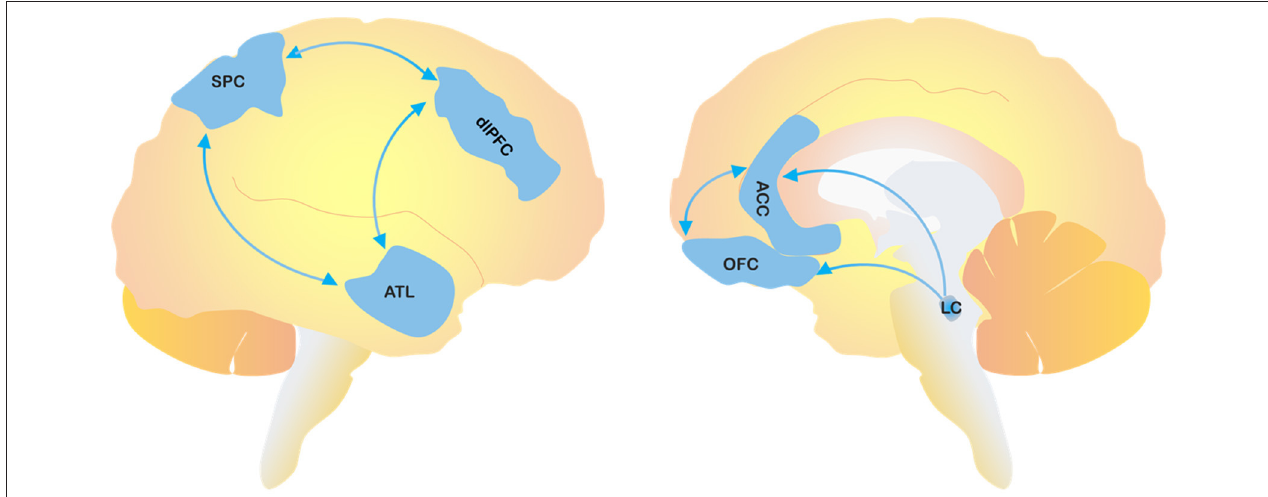
FIGURE 1 | The figure depicts the cerebral areas involved in the pathological process of agitation. SPC, superior parietal cortex; dlPFC, dorsolateral pre-frontal cortex; ATL, anterior temporal lobe; OFC, orbitofrontal cortex; ACC, anterior cingulate cortex; LC, locus